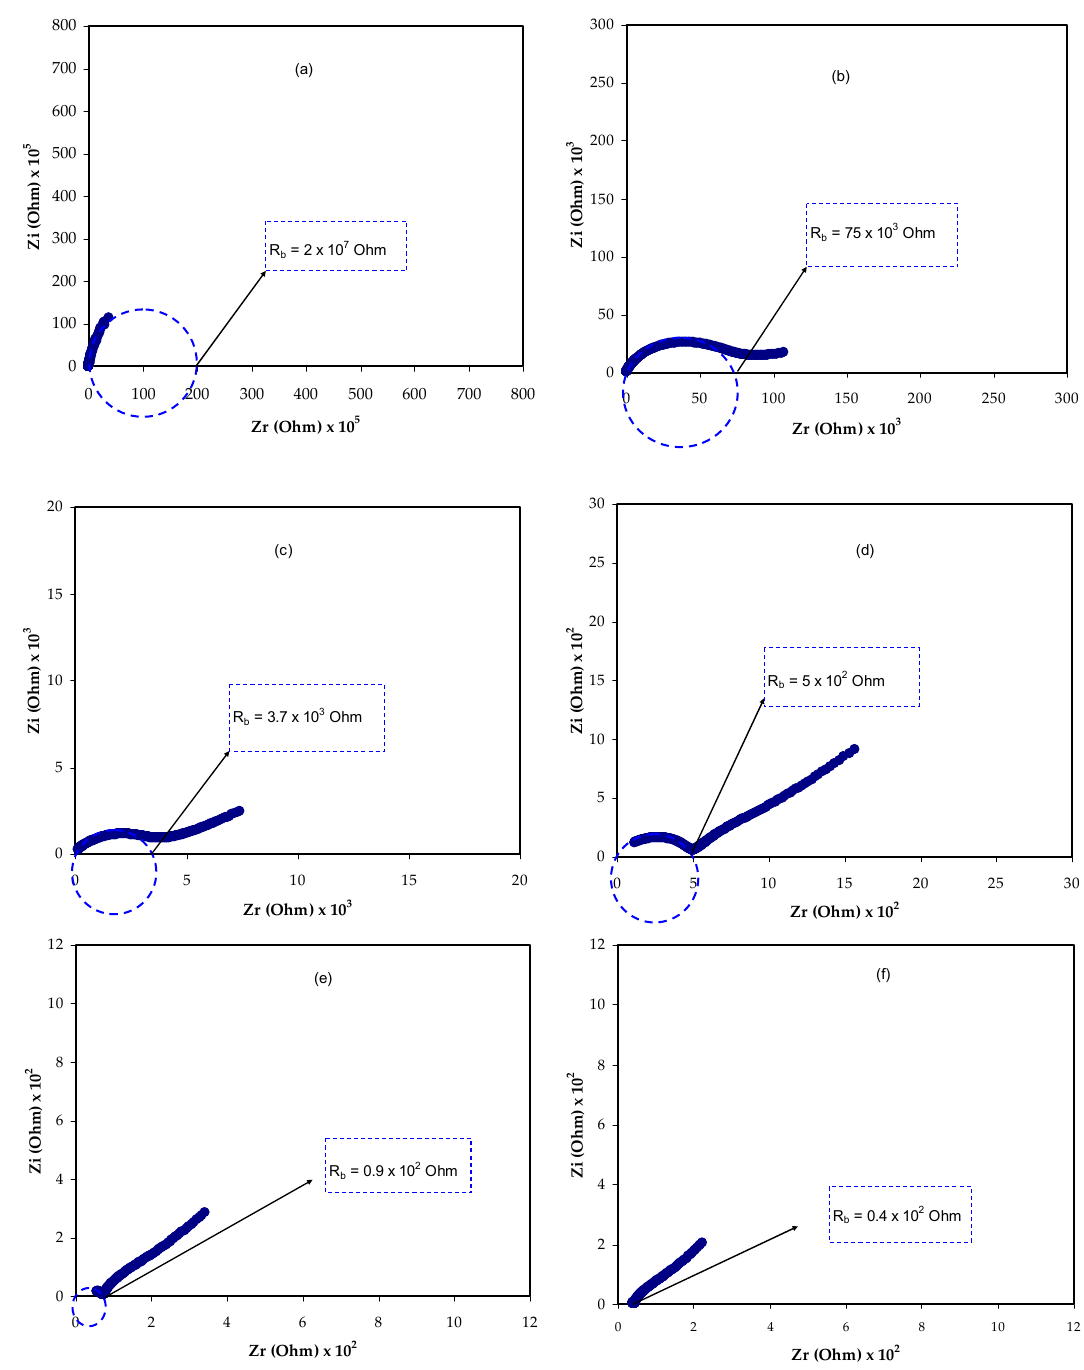
Figure 3. EIS plot for ( a ) BGNN0, ( b ) BGNN1, ( c ) BGNN2, ( d ) BGNN3, ( e ) BGNN4 and ( f ) BGNN5.